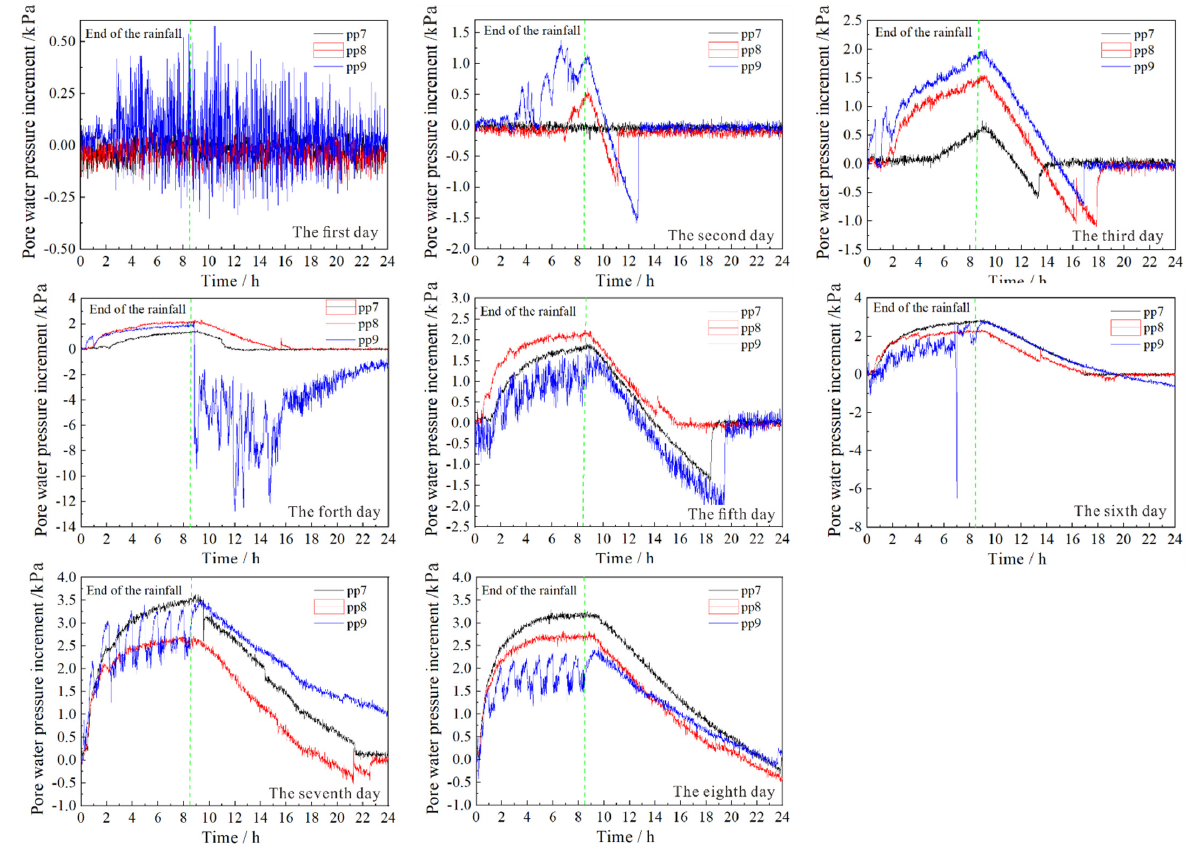
Figure 9. Variation of pore water pressure in the following days, from the first to the eighth (H3 = 0.4 m).